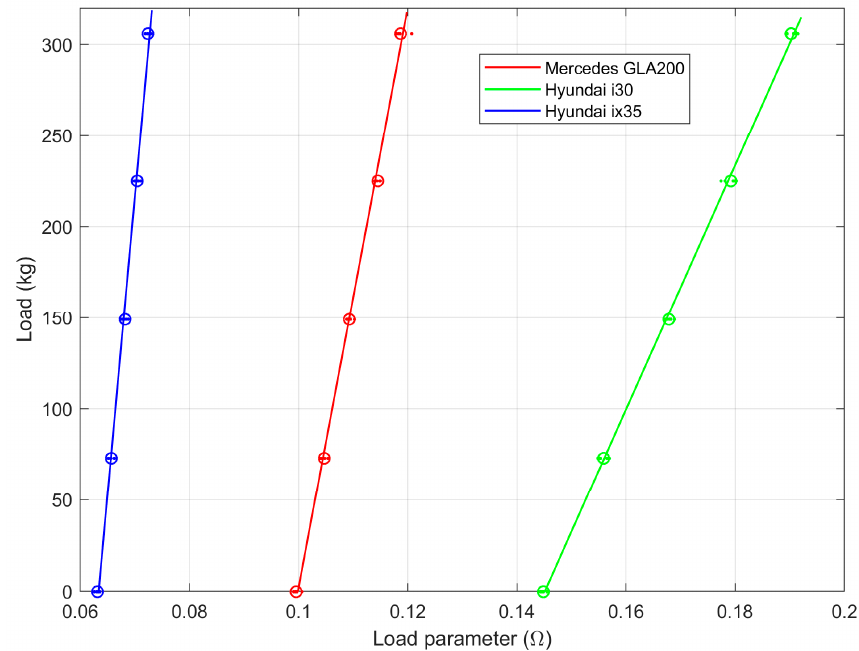
Figure 5. Dependencies between a car load and the load parameter for cars listed in the legend. Dots represent measurements; circles stand for mean values of the measured load parameter (for a set car and load); and lines show the least squares fit to the mean measurements (i.e.,